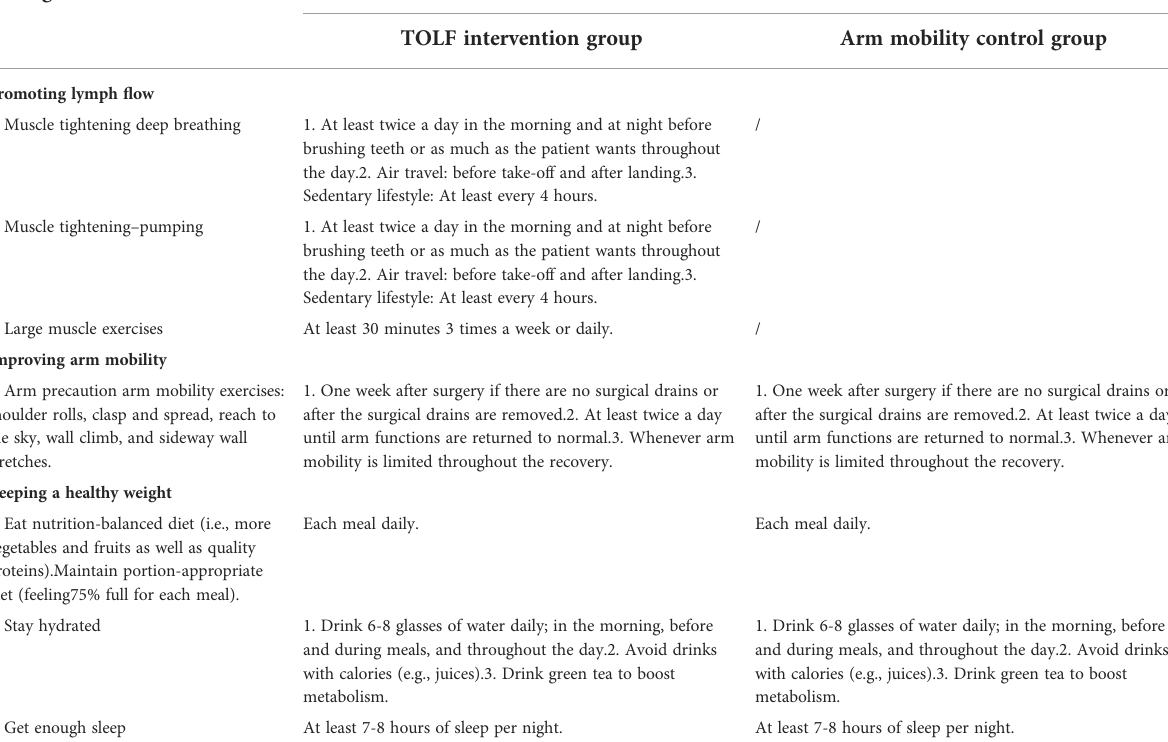
TABLE 1 The intervention strategies for the two groups.